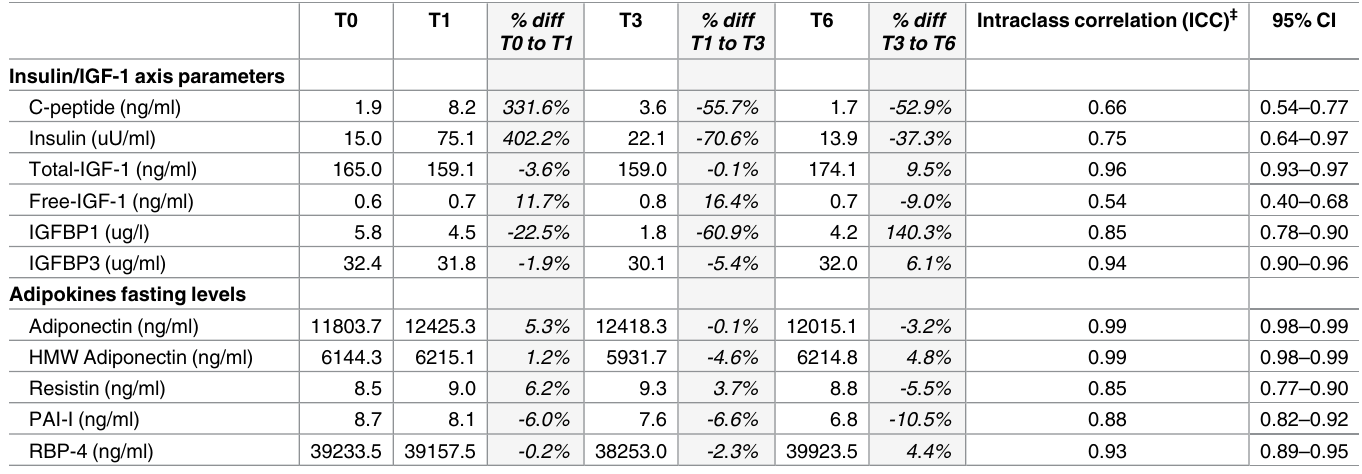
Table 3. Medians of insulin/IGF-1 axis parameters and adipokines after an overnight fast (T0), and 1 hour (T1), 3 hours (T3), and 6 hours (T6) after the researchbreakfast, and intraclass correlations between measurements on blood samples collected at all